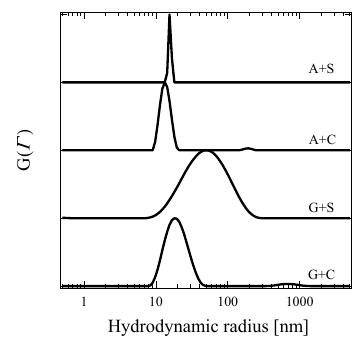
Figure 3. Distribution of hydrodynamic radius of C3Ms for A + S, A + C, G + S, and G + C at the scattering angle of 90°. Data are vertically shifted for convenience.